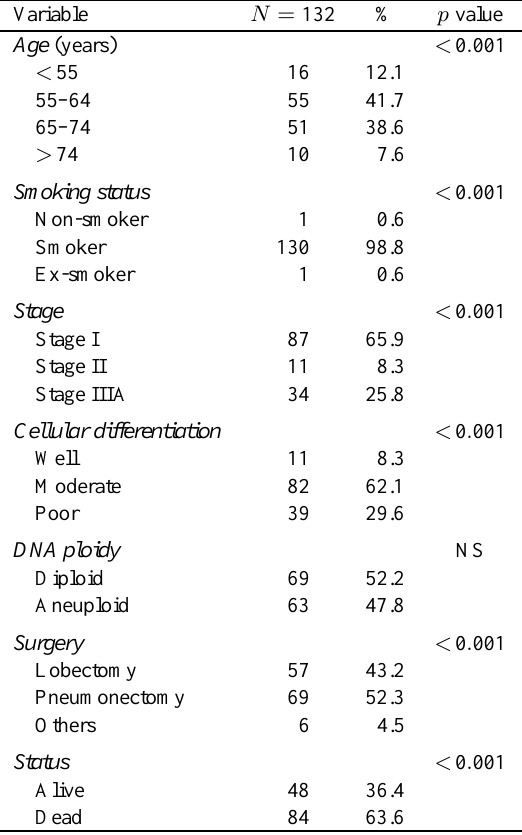
General description of the